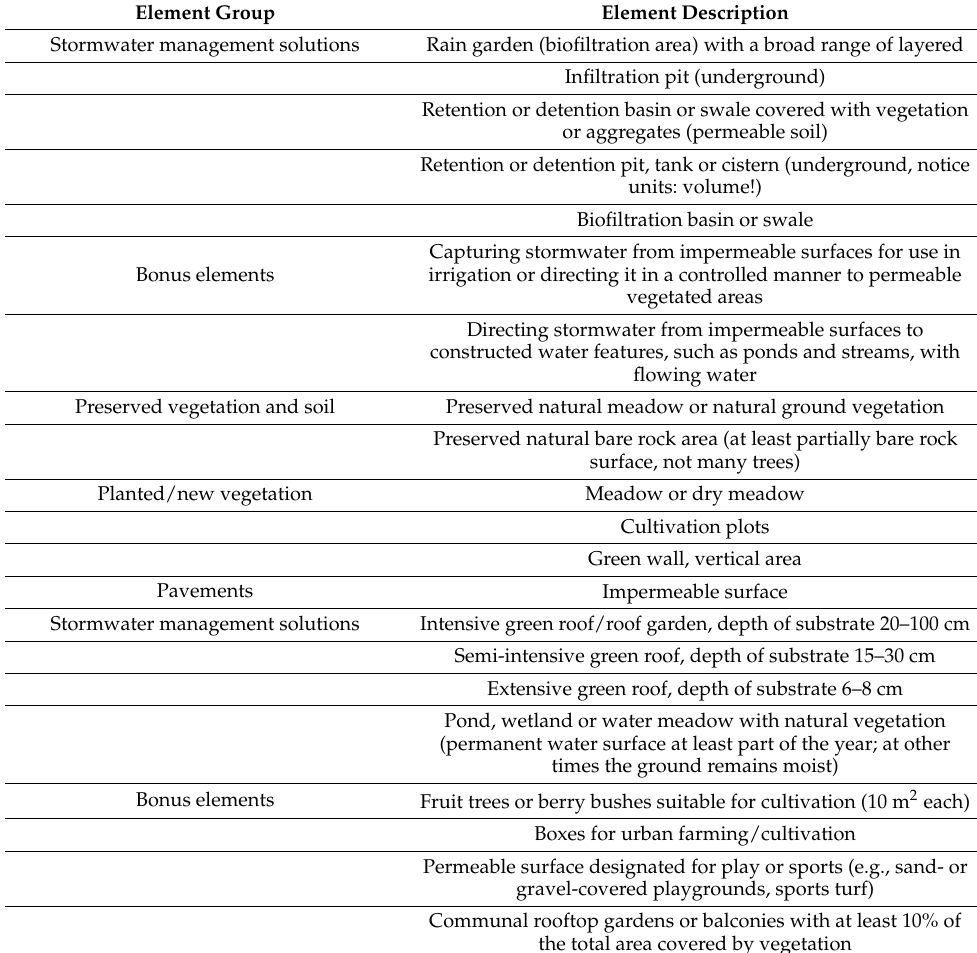
Table A1. Excluded green factor